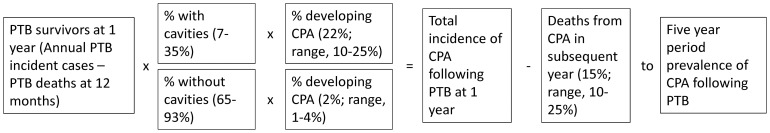
Factors used for assessing the annual incidence and 5-year period prevalence of chronic pulmonary aspergillosis (CPA) as a sequel to pulmonary tuberculosis.